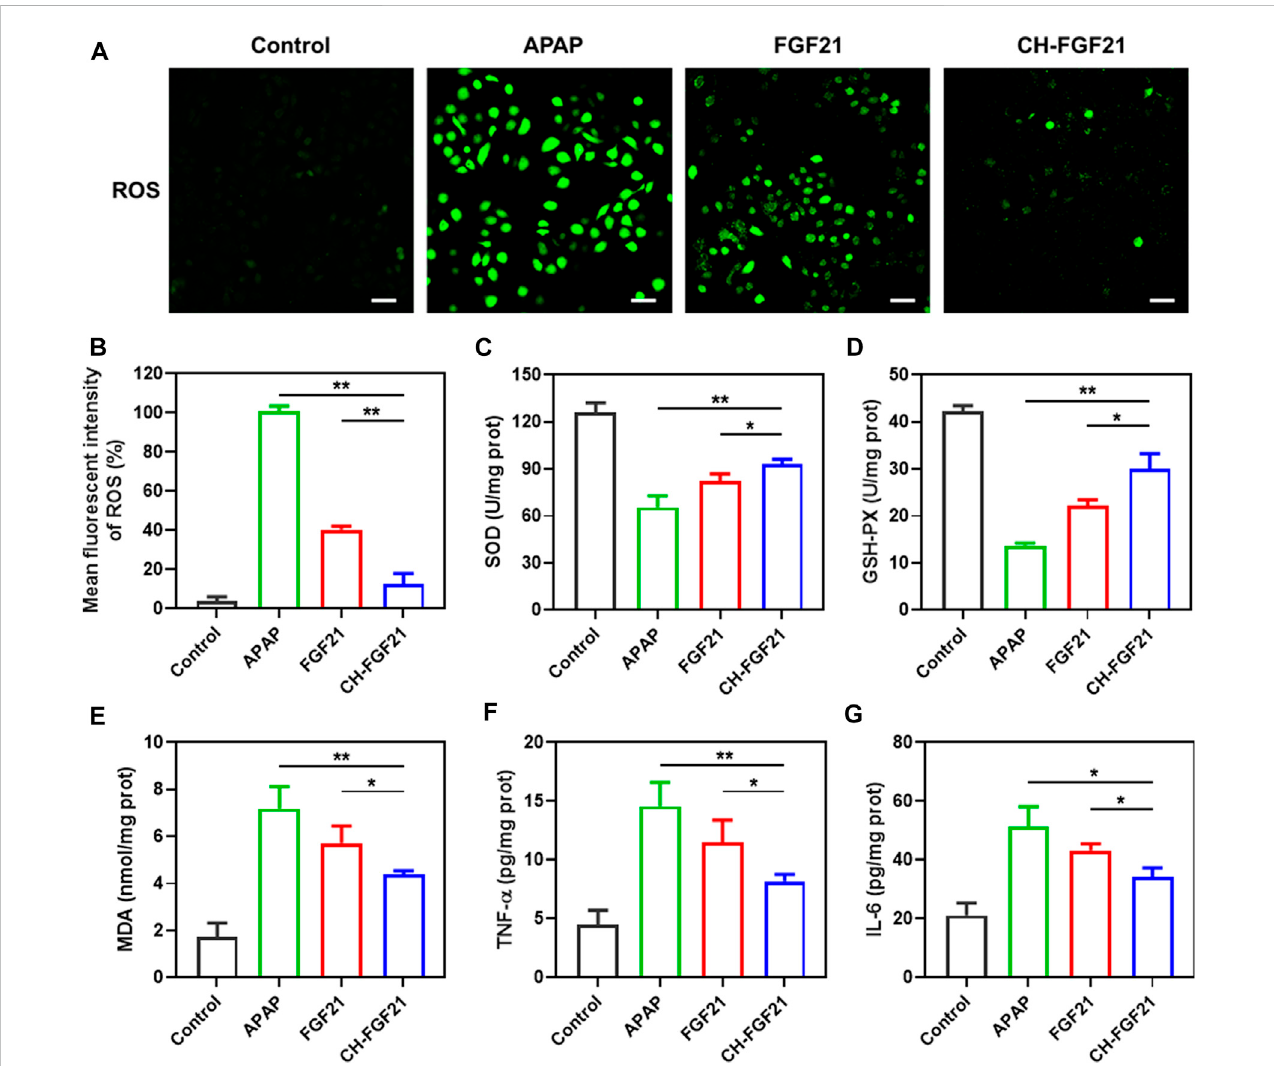
FIGURE 3 Hepatoprotective properties of CH-FGF21. (A) Intracellular reactive oxygen species (ROS) of acetaminophen (APAP)-stimulated AML12 cells after treatmentwithFGF21(100 ng/ml)orCH-FGF21(100 ng/ml)for24 h.Scalebar=100 μ m. (B) Mean fl uorescenceintensityofROS.Levelsof (C) SOD, (D) GSH- PX, (E) MDA, (F) TNF- α , and (G) IL-6 in AML12 cells of each group. Data are the mean ± SD ( n = 3). * p ≤ .05, ** p ≤